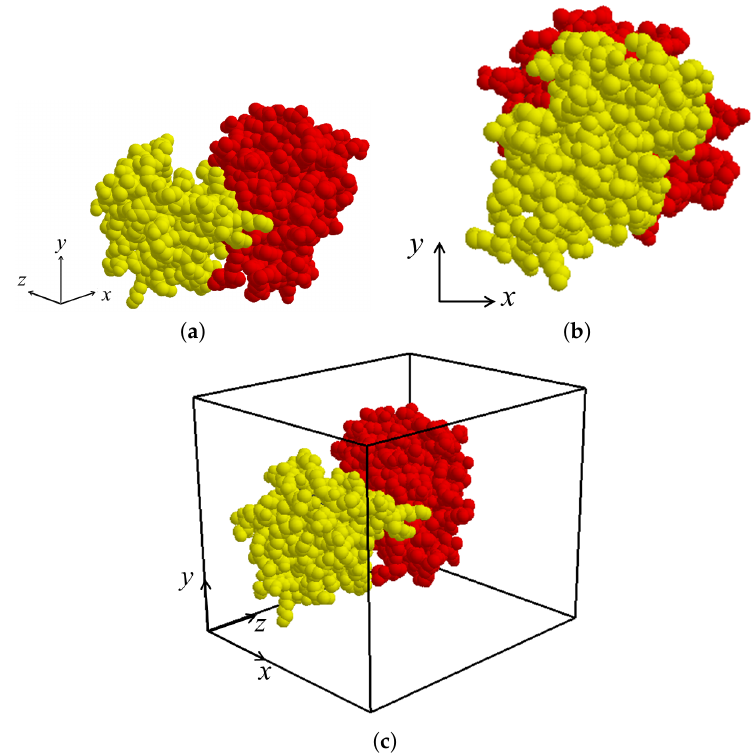
Figure 4. Result of updating orientation of protein complex (PDB id. 2HSN) according to binding direction: ( a ) molecules M A and M B in original position; ( b ) after rigid-body transformation of M A and M B to locate binding direction along z -axis; and ( c ) generated view volume for transformed M A and M B